Question: Generate an informative caption for the figure above.
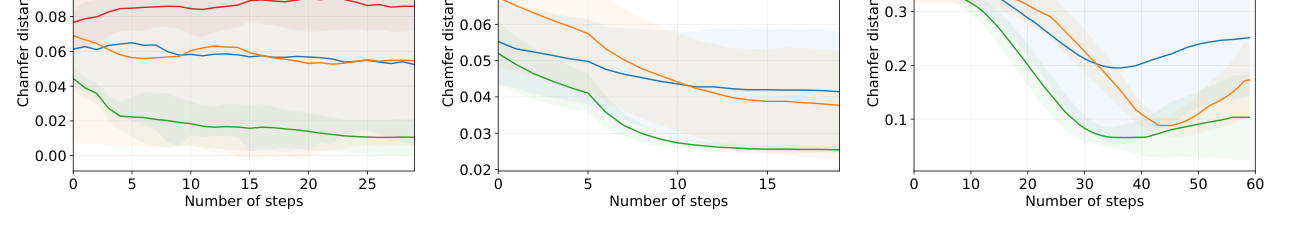
Answer: Real robot deformable object manipulation task results on three different materials. We report the averaged Chamfer distance (meters) over steps.